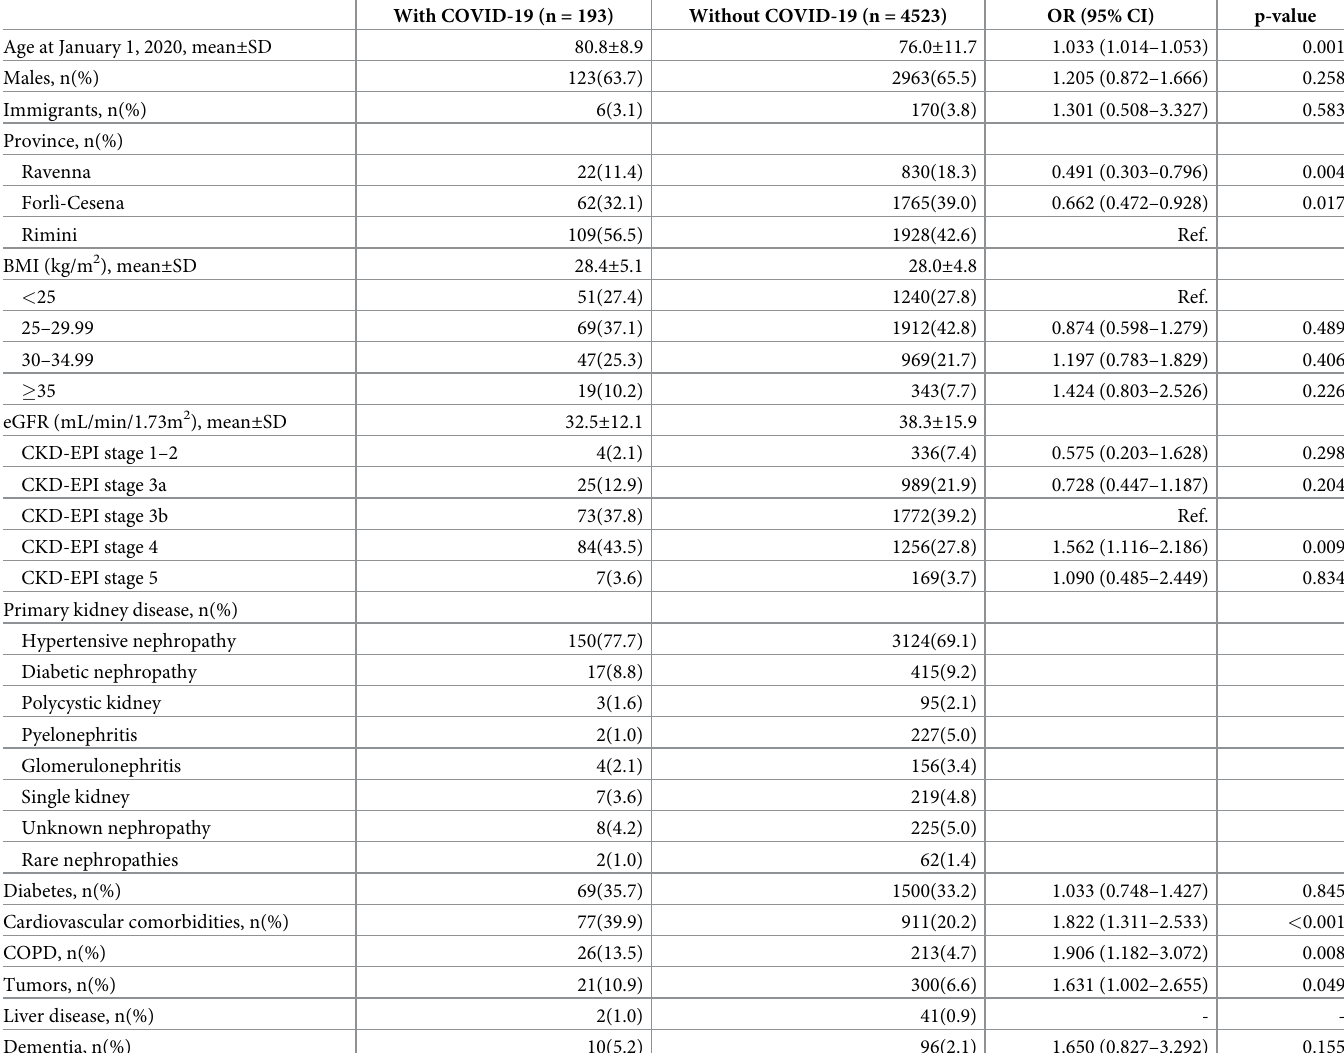
Table 1. Characteristics of CKD patients with and without COVID-19 disease, and predictors of COVID-19. With COVID-19 (n =